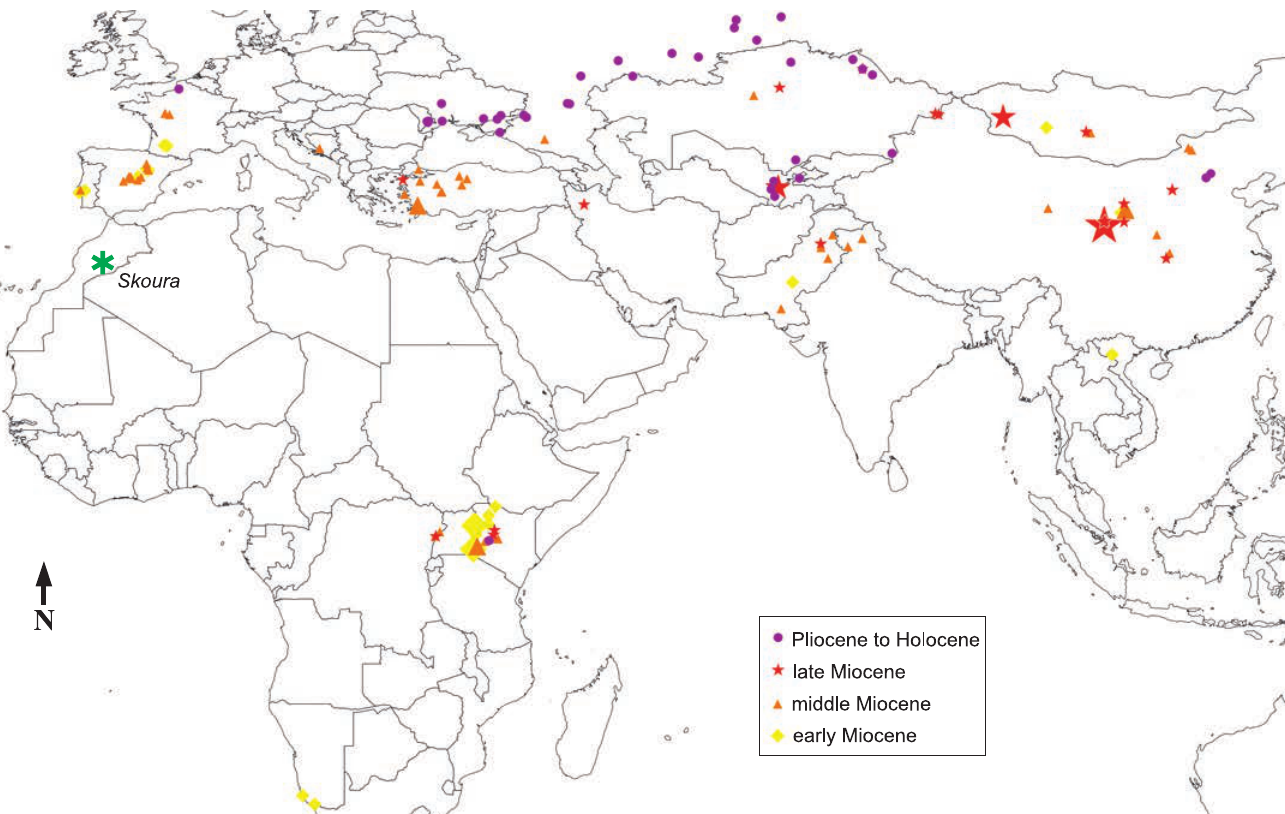
Fig. 5. Distribution map of the Elasmotheriinae. The size of the symbols reflects the number of species in each site (one species for the smallest symbols, up to four for the largest one: Guonigou in China). Eoazara xerrii gen. et sp. nov. is from the area called “Skoura”. Data from Geraads et al.